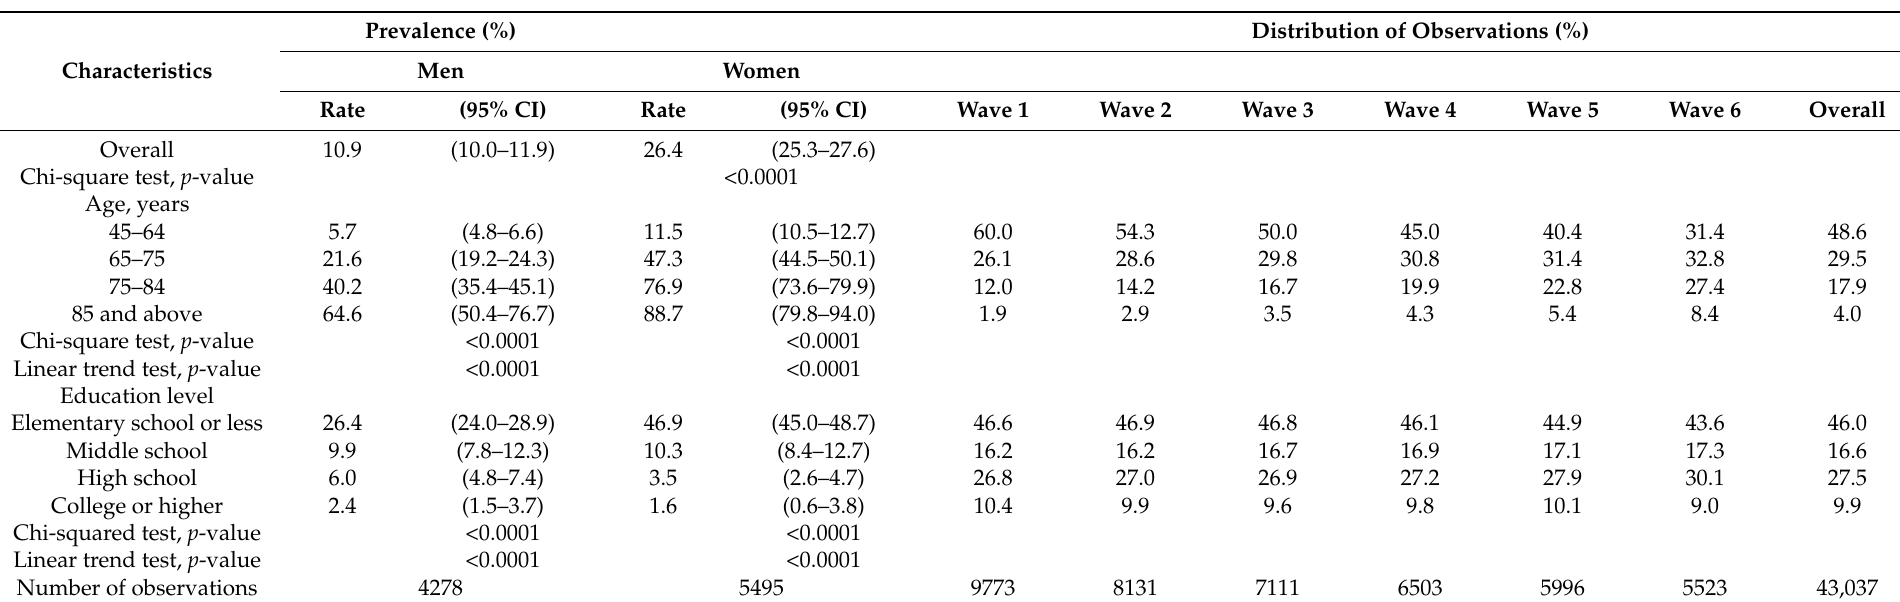
Table 2. Prevalence of cognitive impairment across age groups and education levels by gender at the baseline (Wave 1) and the distribution of observations across age groups and education levels by